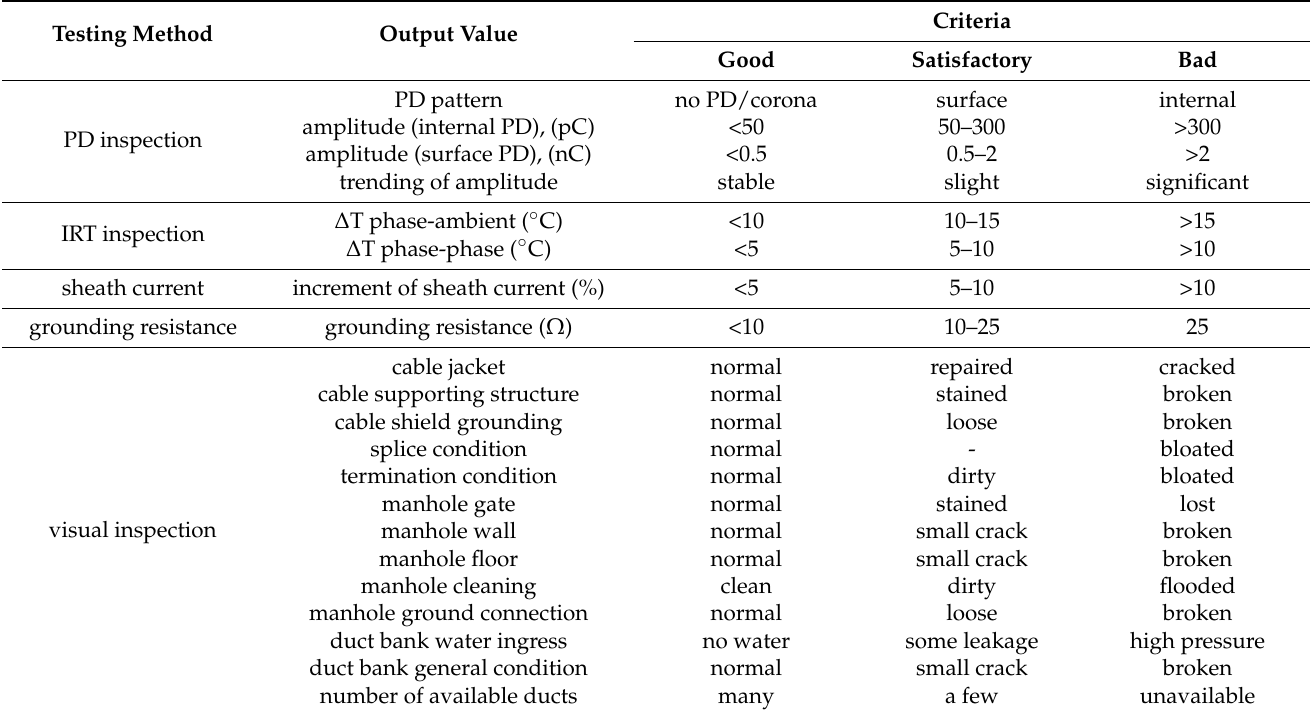
Table 3. Testing and inspection methods for HI calculation